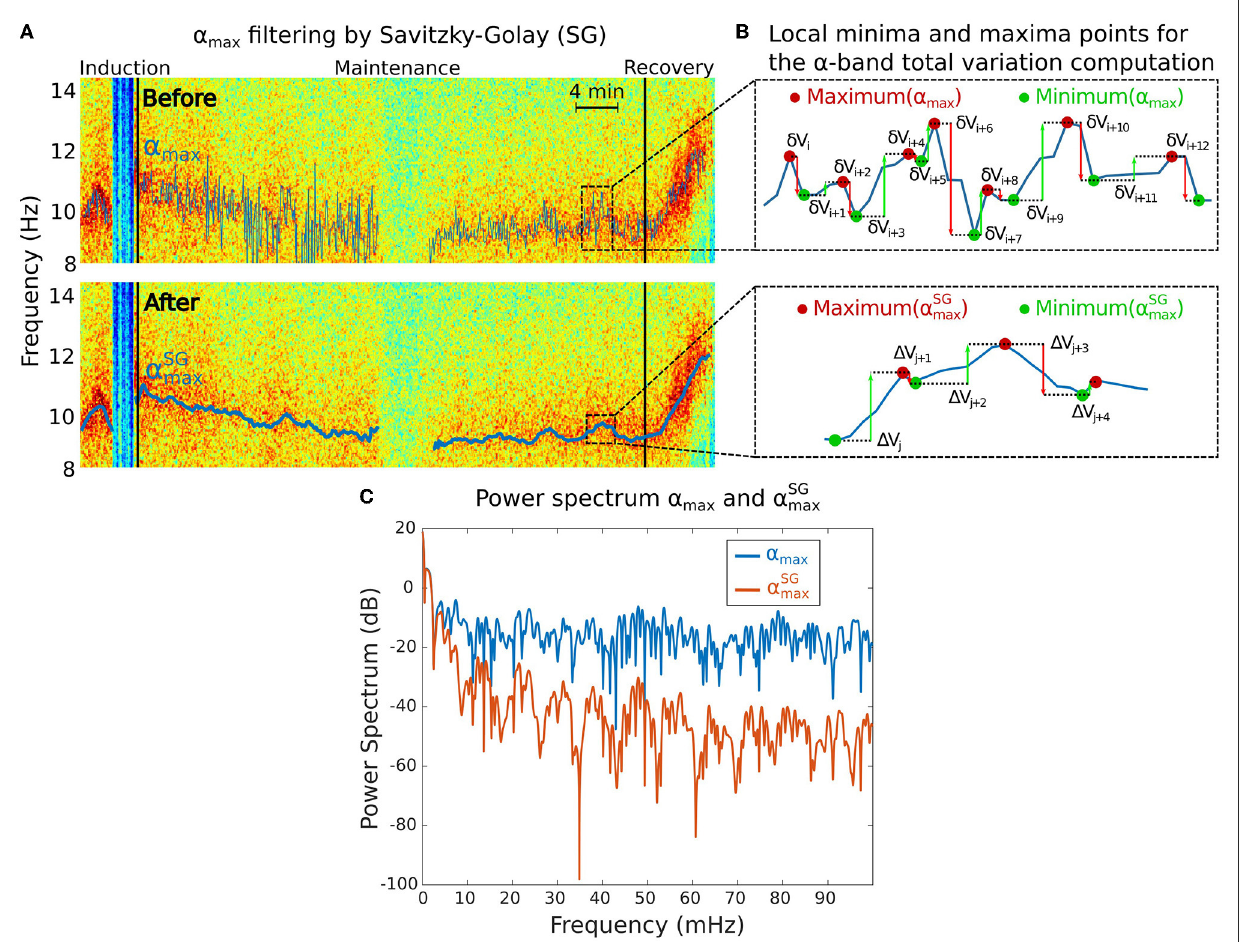
FIGURE2 Total variation V α analysis associated to the α − band. (A) Maximum power frequency α max of the α − oscillations before (top) and after (bottom) applying the Savitzky-Golay (SG) filter to remove the high frequencies. (B) Reduction of the local minima and maxima variations of the α max from the initial signal (top) to the filtered one (bottom). (C) Power spectra of α max before (blue) and after (red) SG filtering showing that only the slowest oscillations remain in the filtered